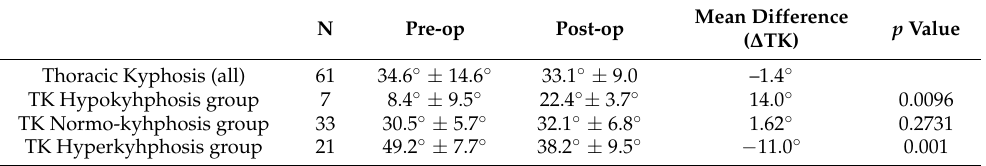
Table 5. Subgroup analysis of TK pre- and post-operatively.